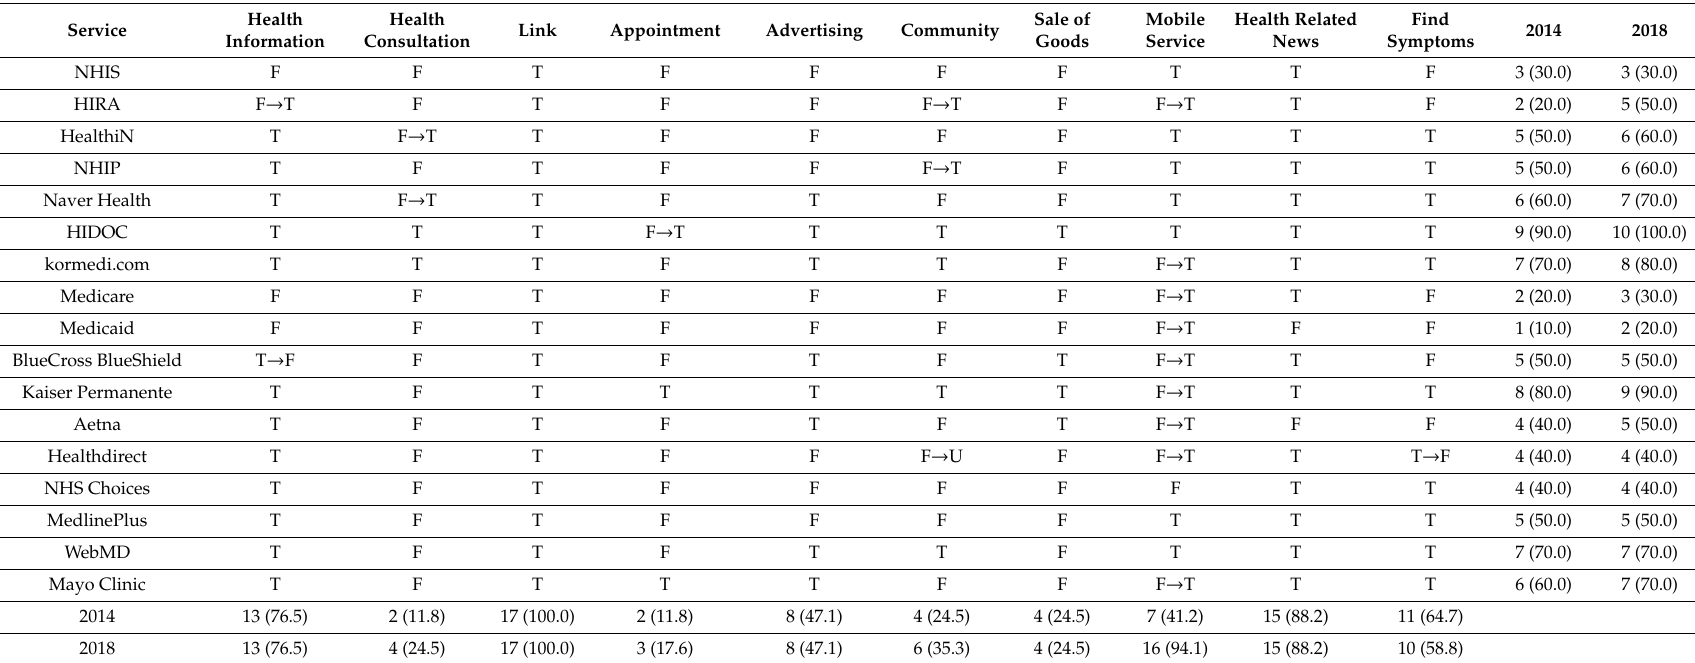
Table 7. Changed service function of the health information portals. (Frequency,